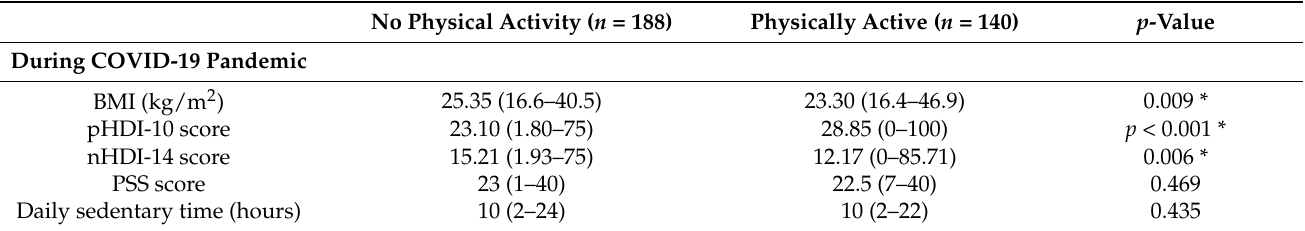
Table 5. Comparison of BMI; pHDI-10, nHDI-14, and PSS scores; and daily sedentary time depending on physical activity status during the COVID-19